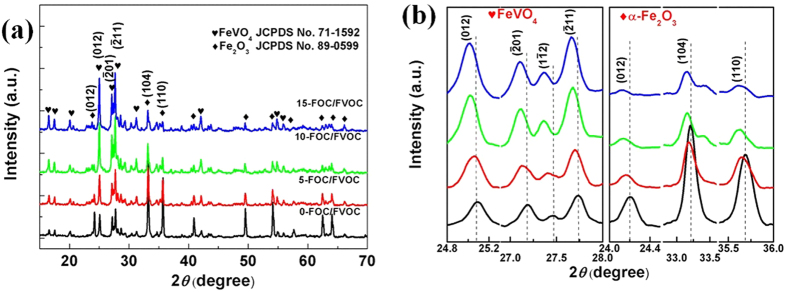
(a) XRD patterns of FOC/FVOC heterojunctions, (b) respectively magnified diffraction peaks of FeVO4 and α-Fe2O3 at 24–36°.